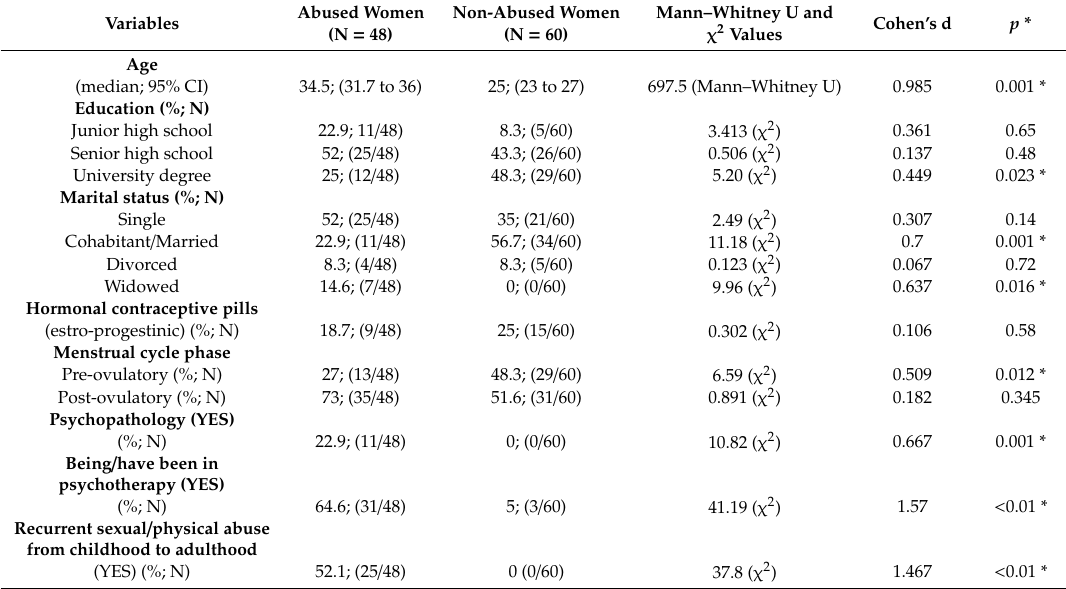
Table 1. Demographic and clinical characteristics of the study